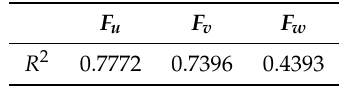
Table 5. Coefficients of determination for F k